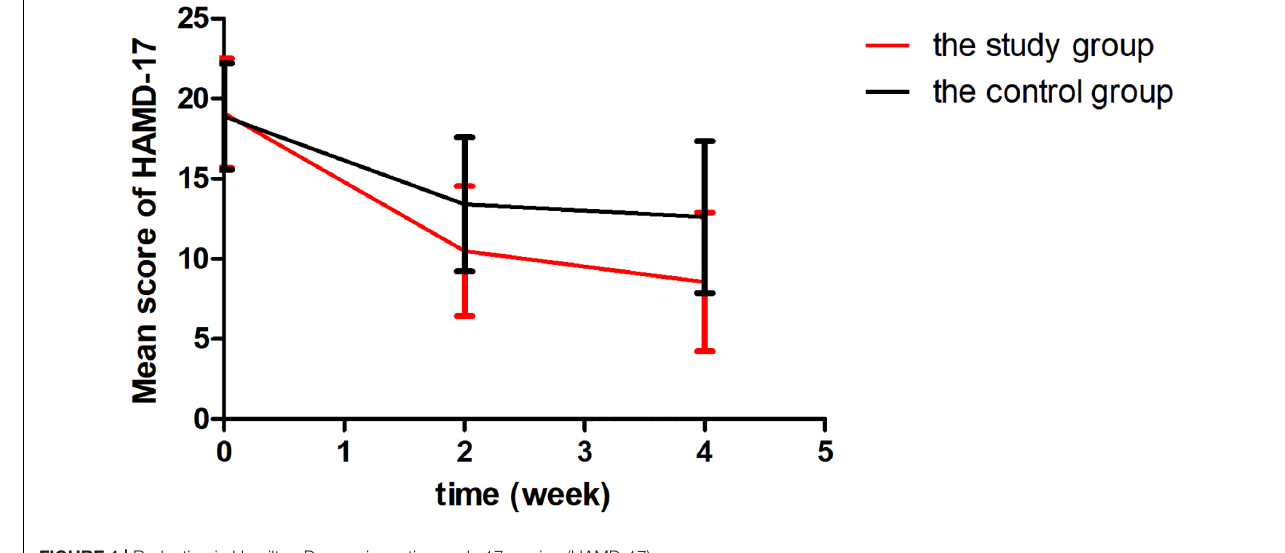
FIGURE 1 | Reduction in Hamilton Depression rating scale 17 version (HAMD-17).